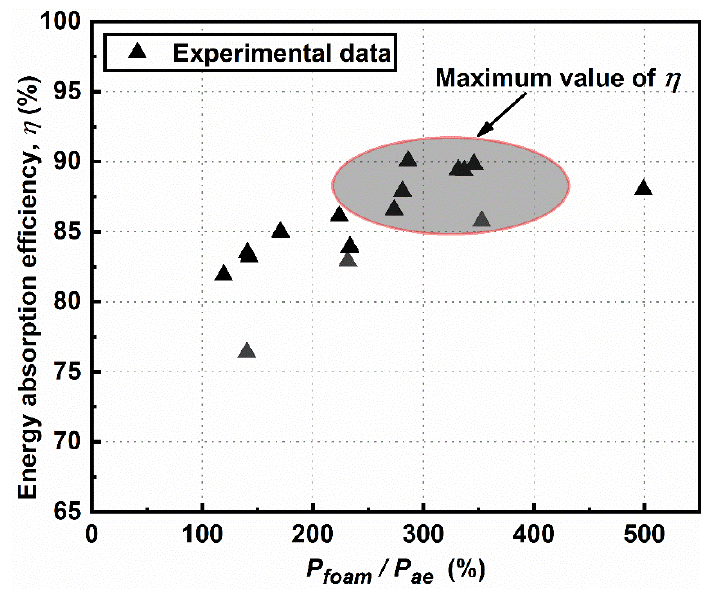
Figure 10. The correlation between the η of all foam-filled tubes and the ratio of mean crushing